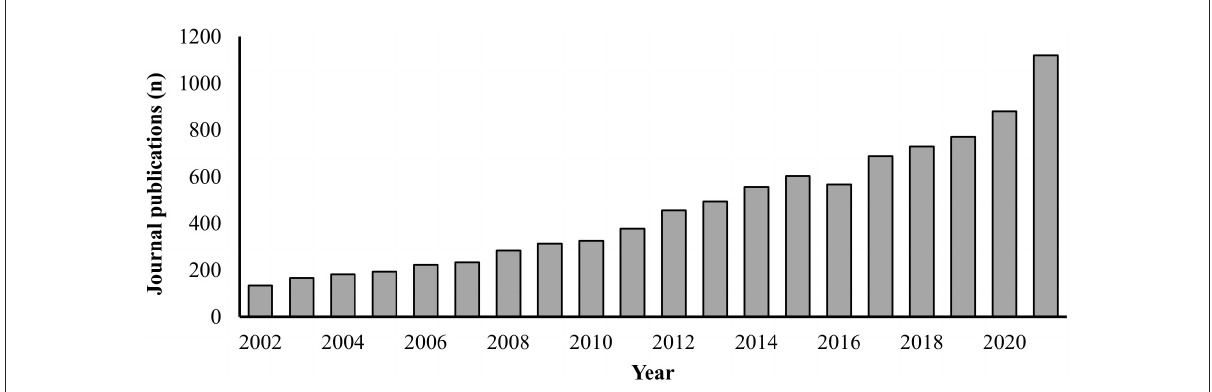
FIGURE1 Growth in the number of basketball Scopus-indexed journal publications between 2002 and 2021. Search conducted using Scopus on 27 October 2022 for “basketball” within “Article title, Abstract, Keywords” field, with “Journal” selected as source type and “Article in Press”